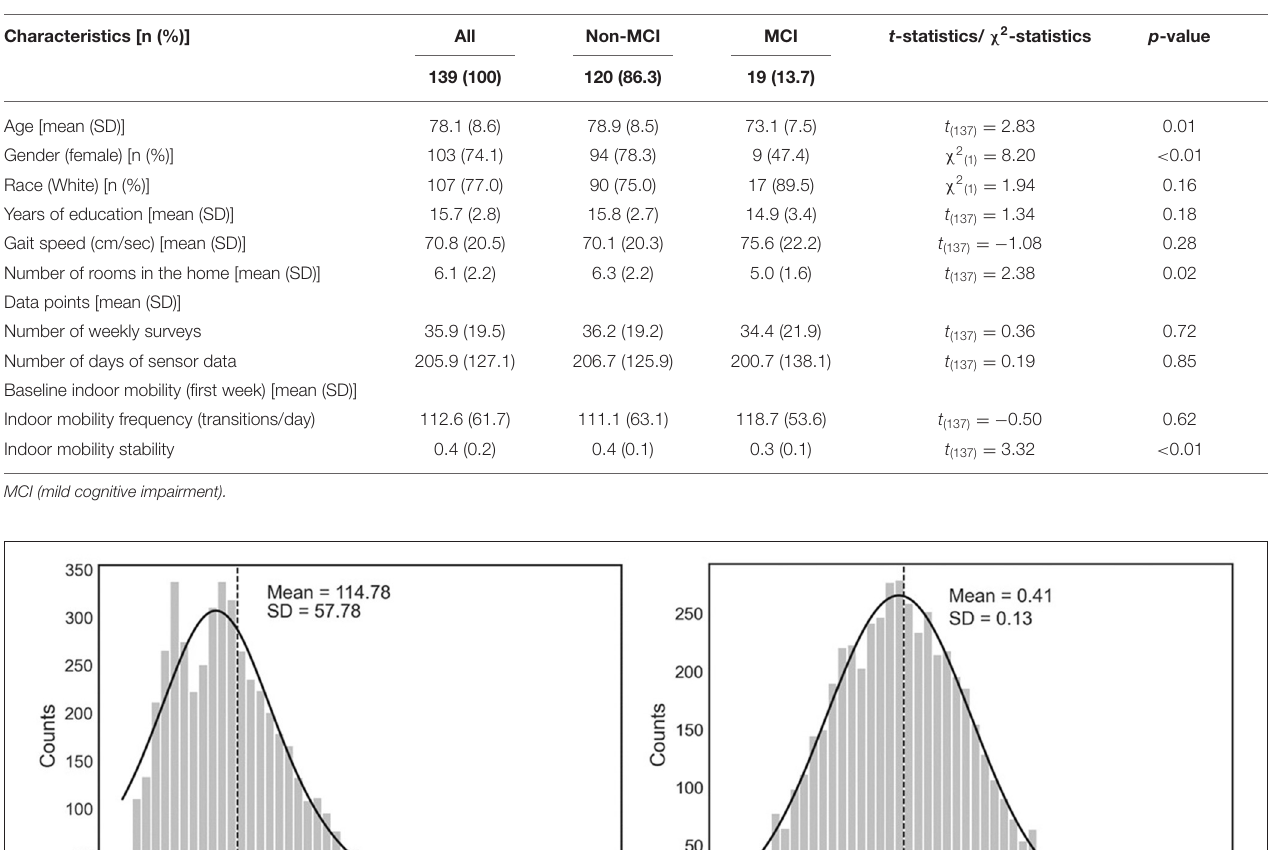
TABLE 1 | Participant baseline characteristics ( n